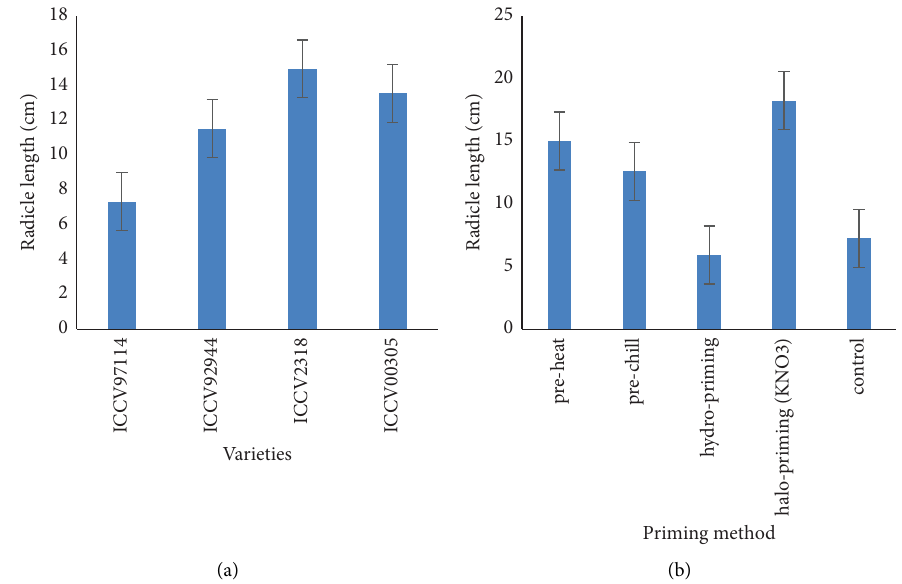
Figure 3: Efect of variety and priming method on radicle length of chickpea. Vertical bars represent standard error bars of means.